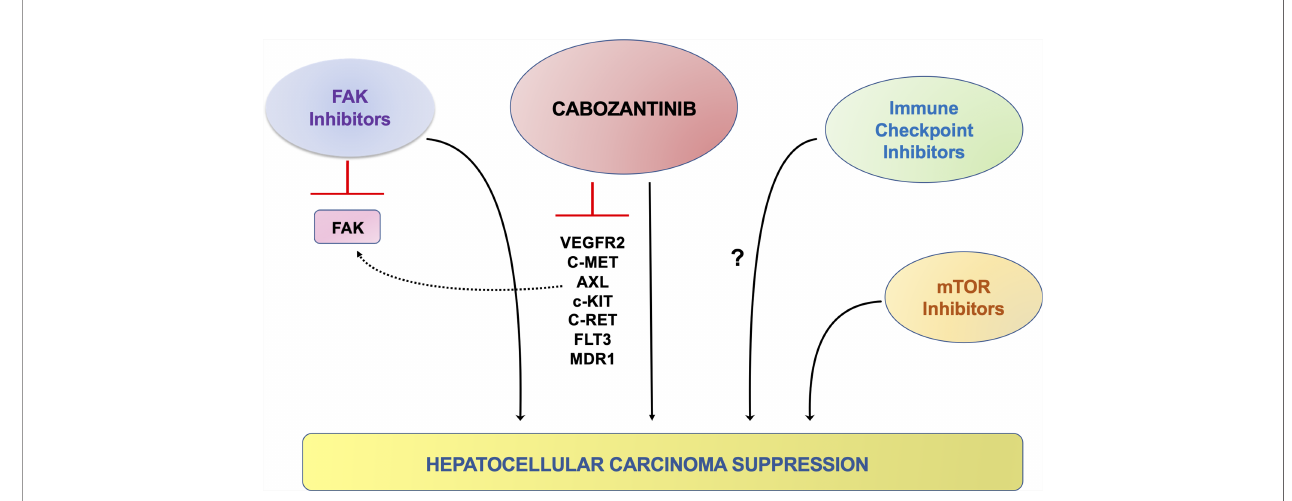
FIGURE 3 | Schematic representation of the possible therapeutic strategies coupling cabozantinib to other signaling inhibitors in preclinical models of HCC. It has been previously shown that cabozantinib treatment on HCC cells leads to the compensatory activation (dotted, black line) of the FAK pathway, in which the use of FAK inhibitors can overcome. A synergistic, antineoplastic effect has also been observed when cabozantinib was co-administered to AKT/mTOR inhibitors. In addition, targeting the IGFR1 and FGFR1 pathways might hinder the resistance of cancer cells to cabozantinib administration. A possible synergistic effect could also be achieved with the concomitant treatment with cabozantinib and immune checkpoint inhibitors, although the data in this regard are contradictory (question